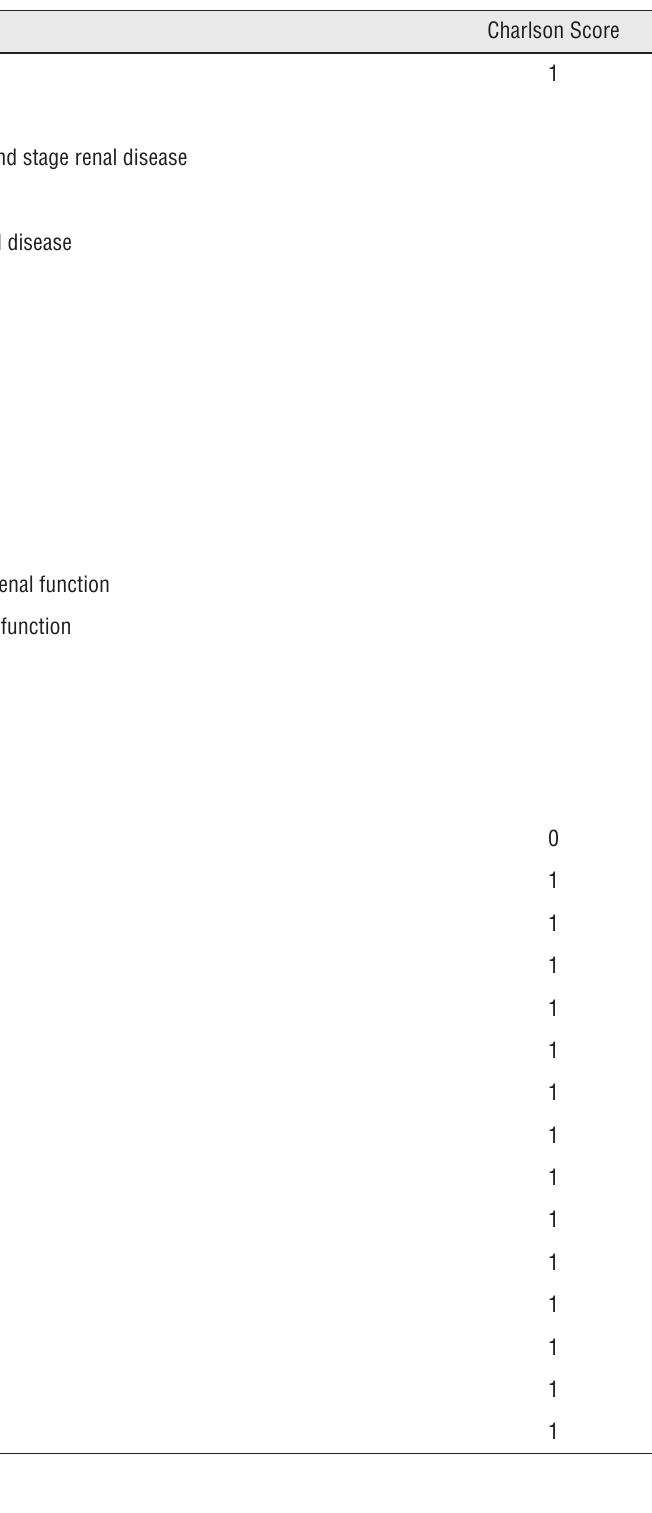
Table 1 - U.S. National Cancer Database (NCDB) Charlson comorbidity index (CCI) criteria and United States Medical Diagnosis IDC-9 Codes